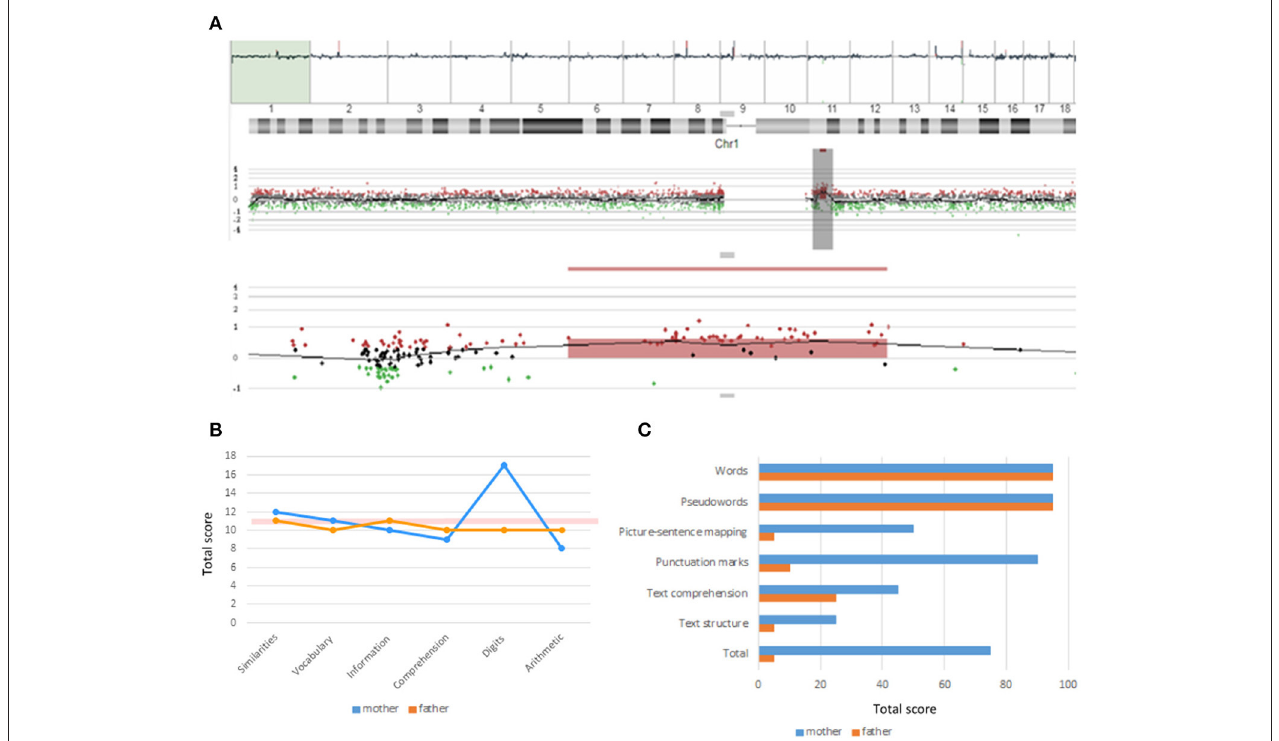
FIGURE 3 | Chromosomal alterations and linguistic profile of the proband’s mother. (A) Screen capture of the array-CGH of the chromosome 1 of the proband’s mother showing the microduplication at 1q21.1. (B) Developmental profile of the proband’s mother according to the verbal component of the WAIS-III (for comparison, the figure includes the profile of the healthy, non-carrier father). The pink horizontal bar shows the normal values. (C) Reading abilities of the proband’s mother according to the PROLEC-SE test (for comparison, the figure includes the profile of the healthy, non-carrier father: the low scores obtained by the father are seemingly explained by his low educational level).